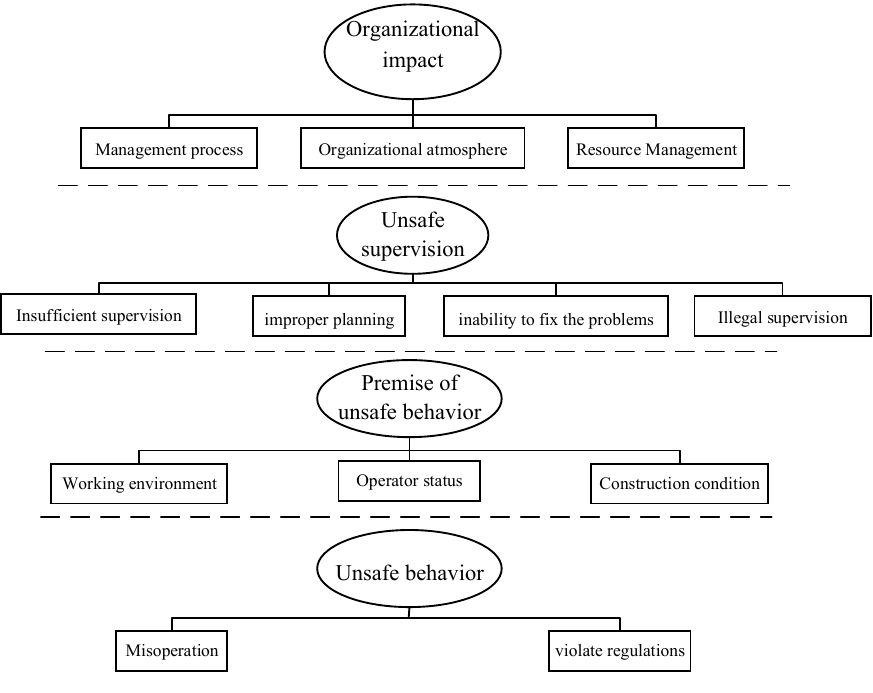
Figure 2. HFACS frame.